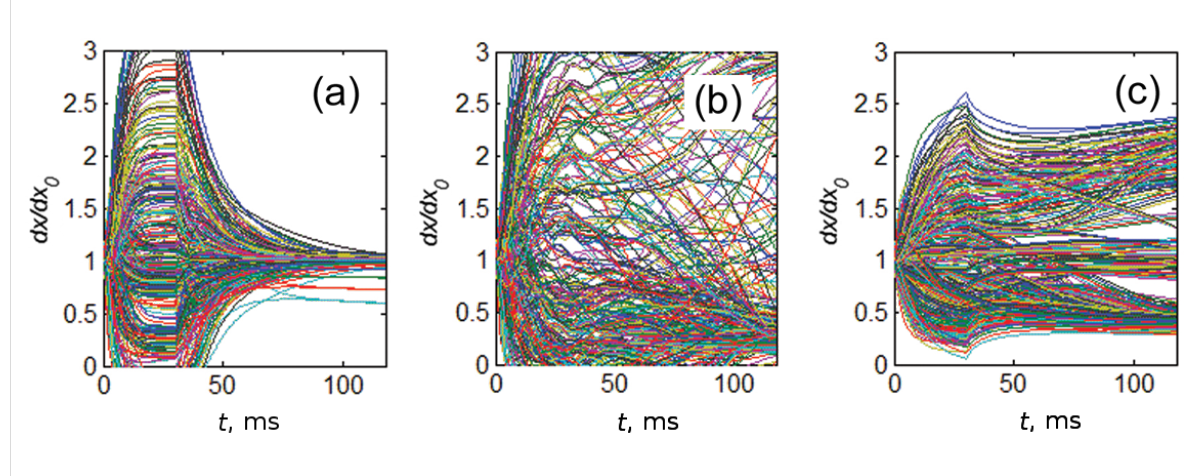
Figure 5: Time evolution of arrays { dx j } of distances j = 1,2,… N x between ends of nearest neighbors dx j = x j +1 − x j during single attachment–detach- ment cycle for the same cases (a)–(c) as before. All the distances are normalized to the distance of original unperturbed periodic system: dx j = dx 0 at t = 0. Each line in the plots corresponds to a time-depending distance between one pair of the neighbors dx j = x j +1 − x j . In attached state, all the fila- ments tend to a configuration, which represents certain compromise between stiffness, adhesion to the surface and mutual interaction of the fibers. After detachment, the system relaxes to asymptotic configuration corresponding to a compromise between the stiffness and mutual interaction of the fibers only.